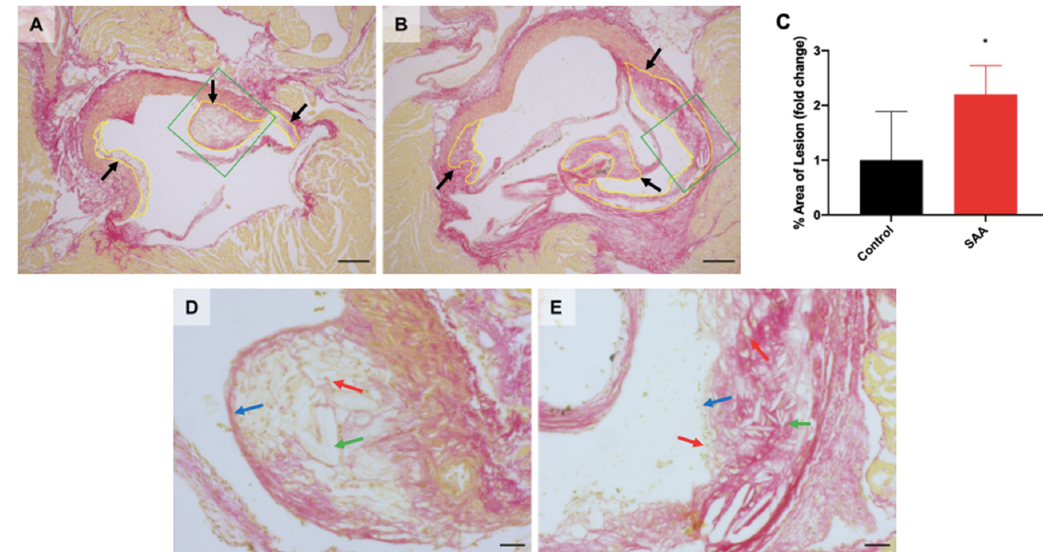
Figure 10. SAA administration causes atherosclerotic lesion development at aortic valve leaflets. Male ApoE − / − mice were randomly allocated to ( A ) the vehicle control (administered 100 µL PBS every 3 days for 2 weeks) and ( B ) the SAA group (administered 12 µg SAA protein every 3 days for 2 weeks). The aortic sinus from each mouse was harvested 16 weeks after cessation of SAA treatment and fixed in situ before embedding and sectioning (5 µm). Aortic sections were dewaxed then rehydrated before staining with haematoxylin and picrosirius red (PSR) solution. Slides were visualised using an Axio Scope.A1 light microscope at 5× magnification (scale bar = 200 µm). For all images shown, cardiac muscle tissue is stained with haematoxylin (brown) and collagen with PSR (red). The black arrows and yellow outlines indicate lesion formation localised at the root of the valve leaflets. The green polygons indicate the field of view magnified at 20×. Representative images show atherosclerotic lesion formation from n = 5 (control), n = 7 (SAA). ( C ) The total lesion size for each sample was quantified using a freehand drawing tool (ImageJ, version 2.0) and calculated as percentage of total area. Data shown as relative mean ± SD. * Different to the control group; p < 0.05. High magnification (20×, scale bar = 40 µm) images of atherosclerotic lesions at the aortic roots in the vehicle control ( D ) and SAA groups ( E ) were obtained at the fibrous caps (blue arrows) where foam cells (red arrows) and cholesterol clefts (green arrows) can be visualised.